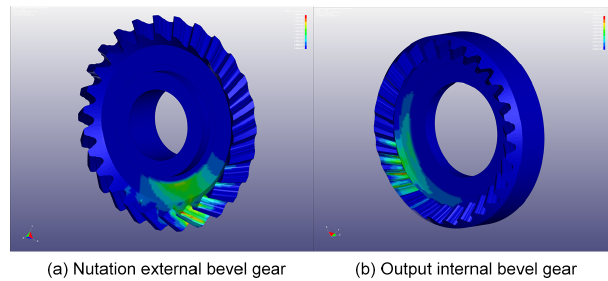
Figure 8. Stress distributions on the double circular-arc spiral bevel gears.